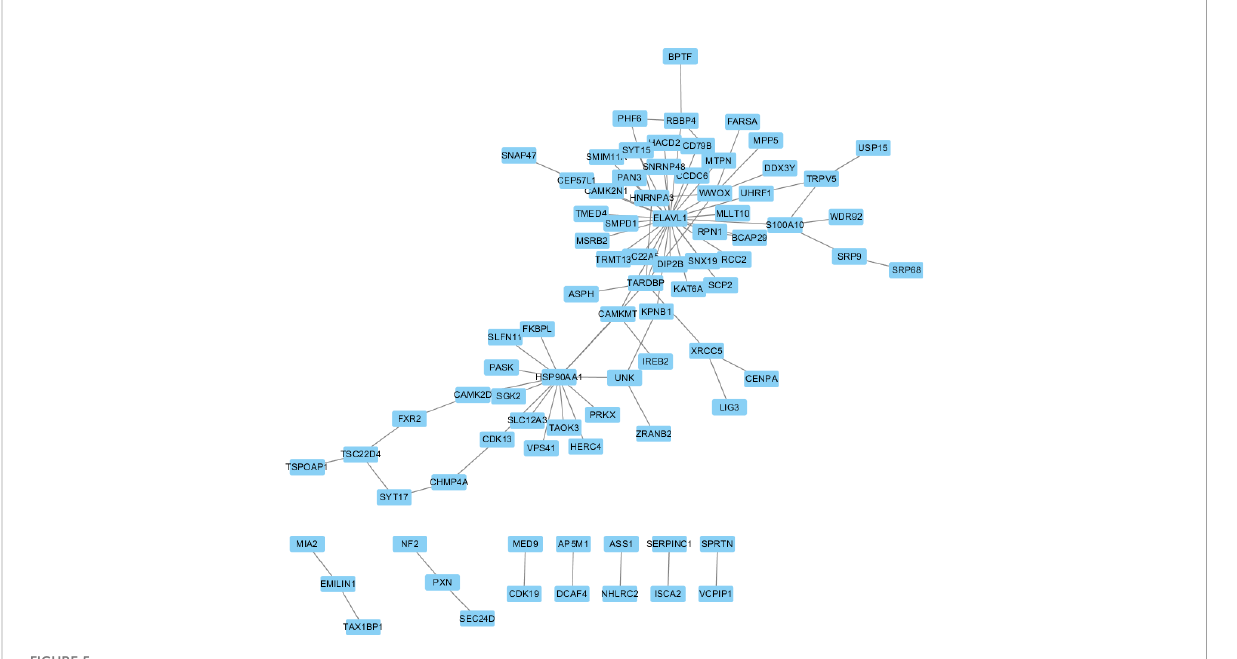
FIGURE 5 Protein-Protein interactions between